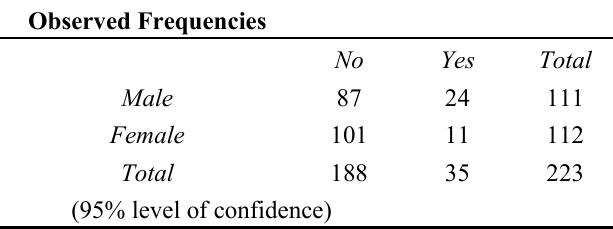
Table 8. Cross tabulation analysis between gender and none of